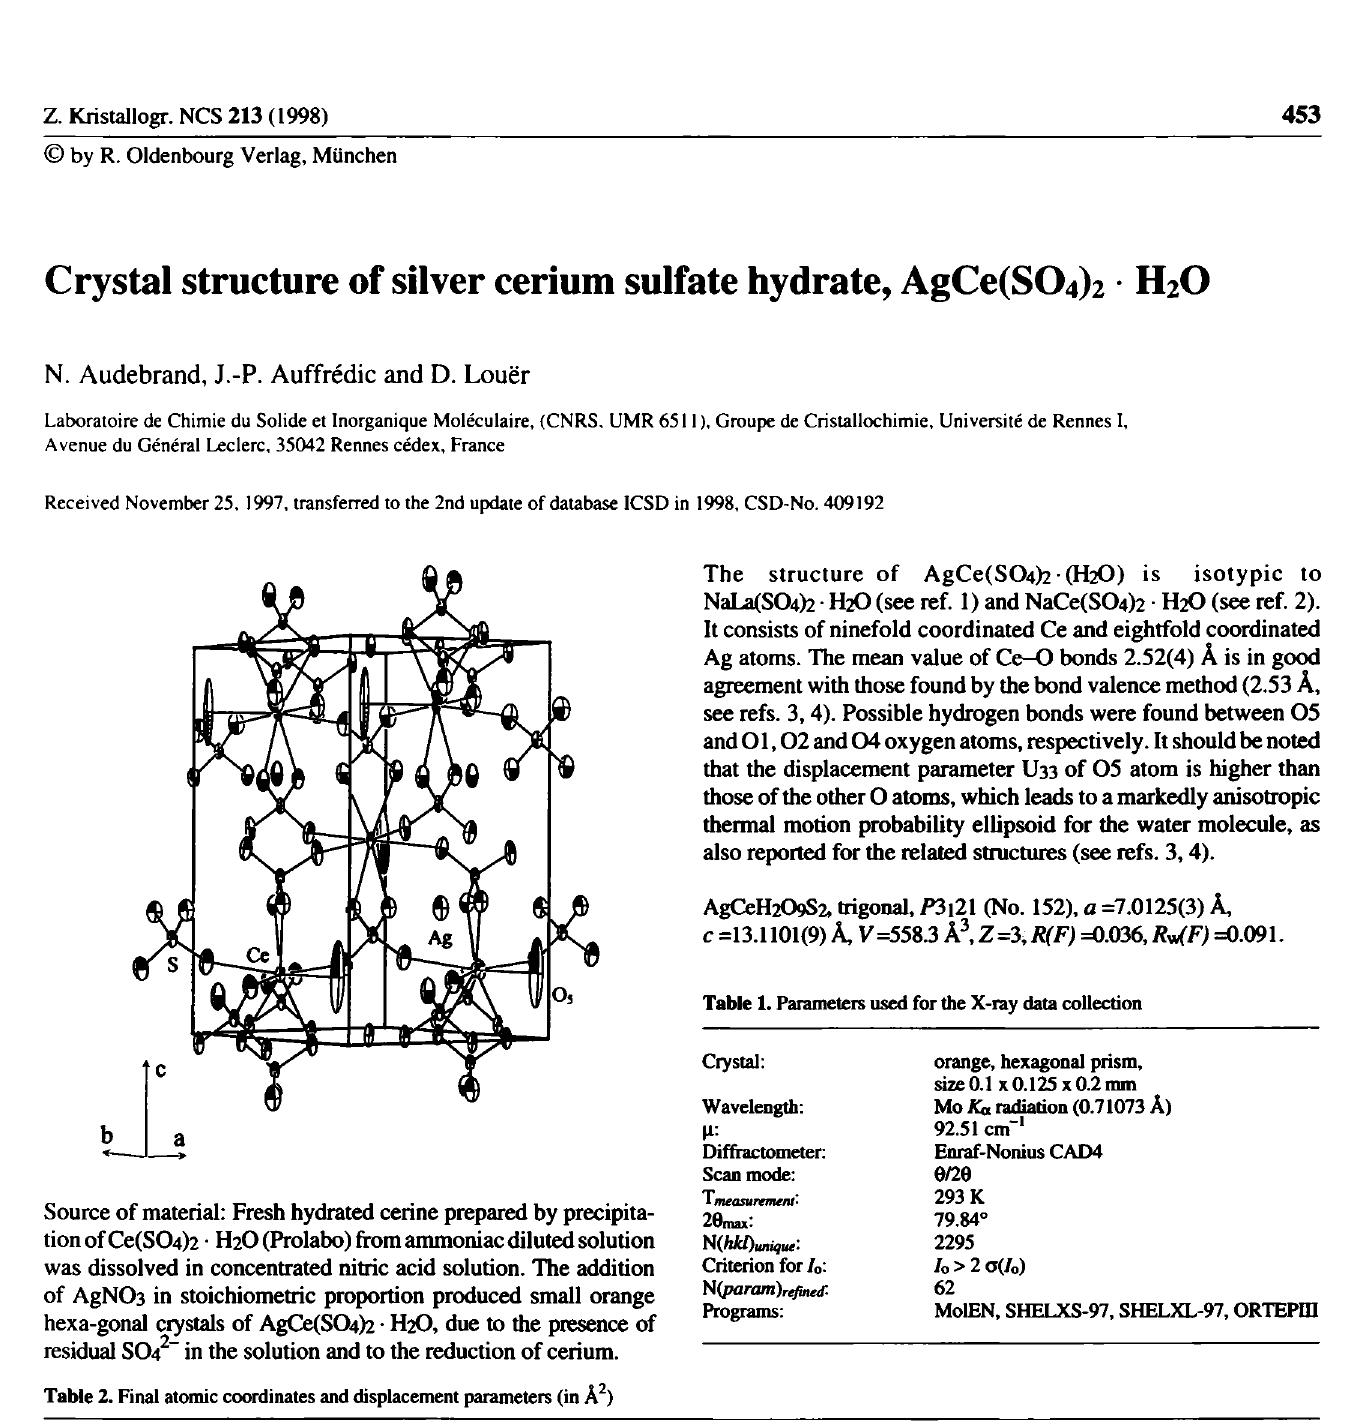
Table 2. Final atomic coordinates and displacement parameters (in Â^)